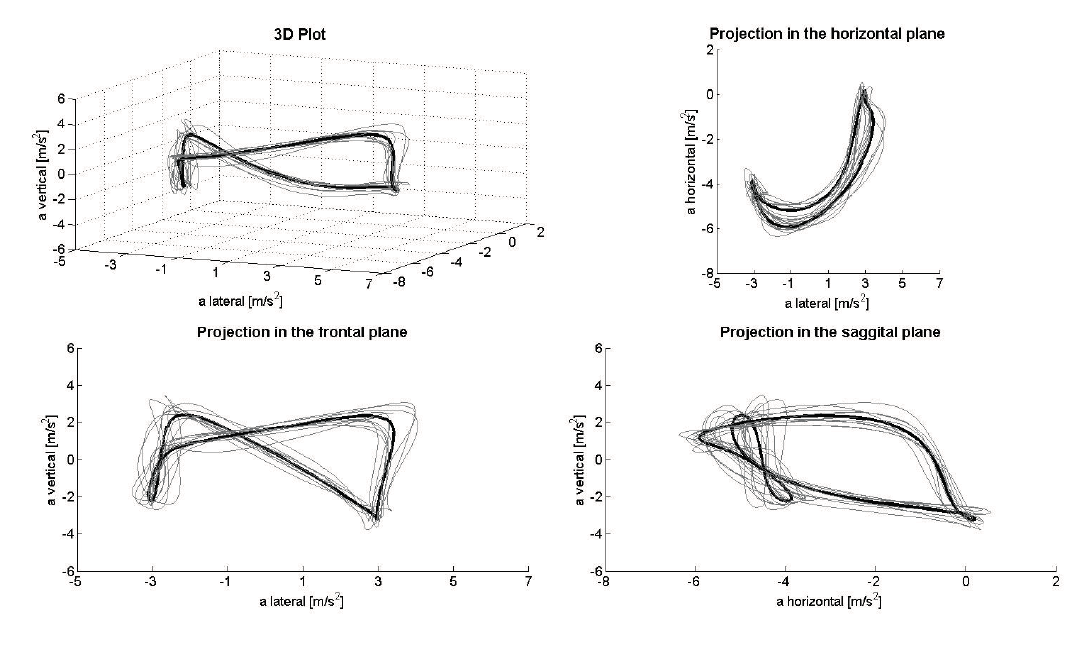
Figure 1. Acceleration during G2L in the total space ( upper left ) and frontal ( lower left ), horizontal ( upper right ) and sagittal planes ( lower right ). These data have been filtered with a Gaussian for higher frequencies (90-ms standard deviation). Due to movement of the trunk (where the Smartphone was attached) within a cycle, the acceleration signals do not always represent the true components (especially in the vertical and horizontal